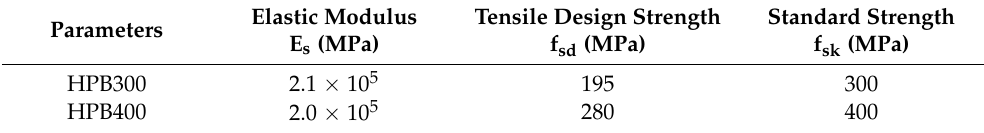
Table 2. Properties of reinforcement used in this